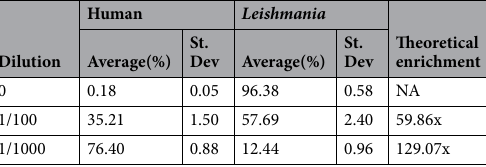
Table 1. Proportion of reads mapping to respectively human and Leishmania genomes in control conditions and in samples diluted 1/100 and 1/1000 with human RNA. The last column indicates how many times SL-seq enriched the Leishmania mRNA compared to the Illumina kit.